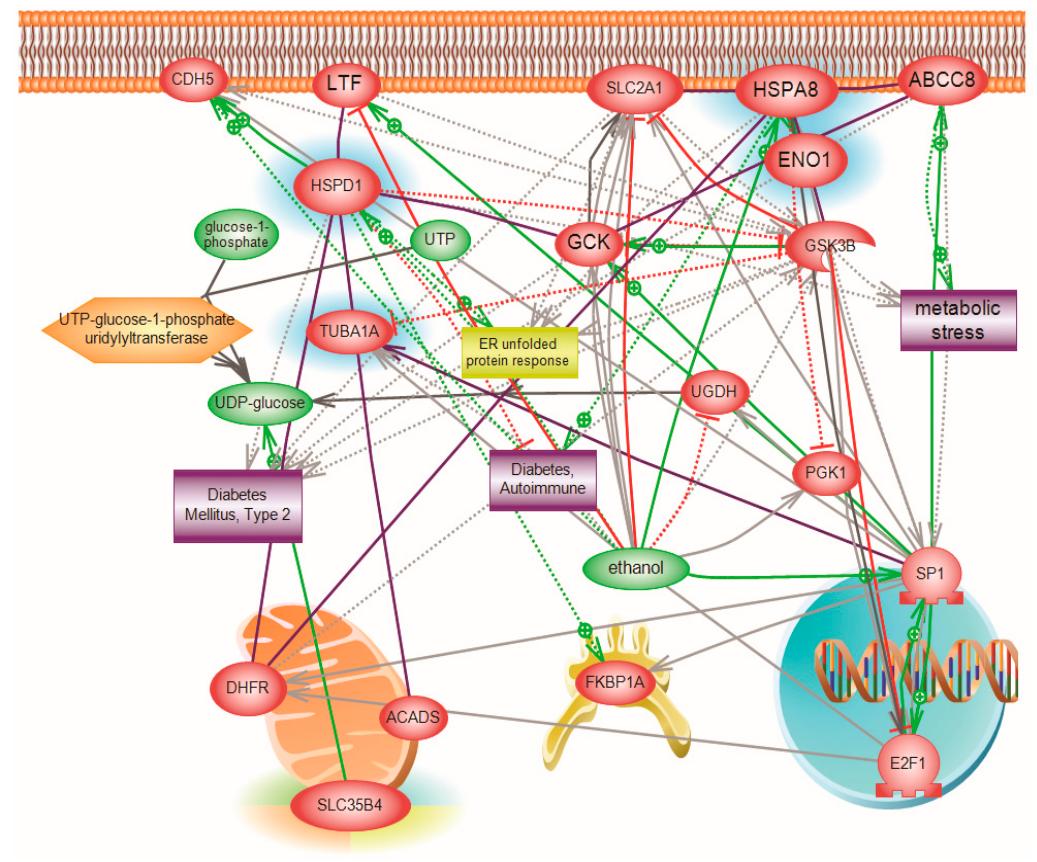
Figure 6. Pathways influenced by identified altered targeted protein. Systems biology analysis of the biological process and molecular function of the four identified genes (HSPD, HSPA8, TUBA1A, and ENO1). The network was generated using the “direct interaction” algorithm to map cellular processes and interactions among altered genes. Of interest, global Pathway analysis revealed an association of these genes to diabetes and to SLC35B4 . Altered genes are shown in blue color.